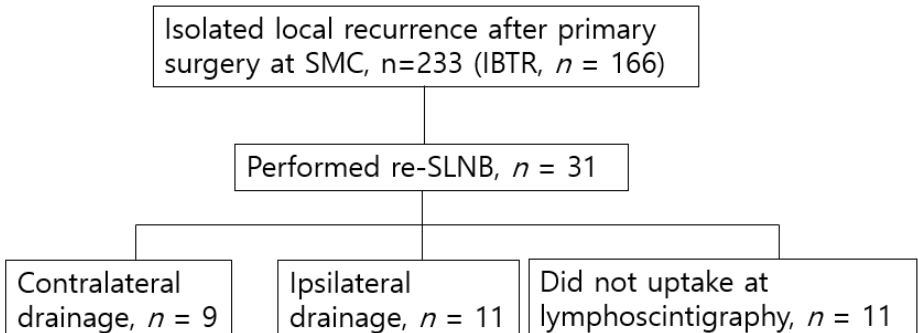
Figure 1. Schematic diagram for patient selection. SMC, Samsung Medical Center; IBTR, ipsilateral breast tumor recurrence; re-SLNB, re-sentinel lymph node biopsy.